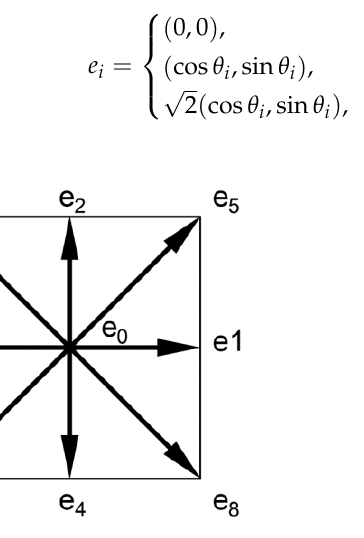
Figure 1. D2Q9 velocity sets with nine directional discretized